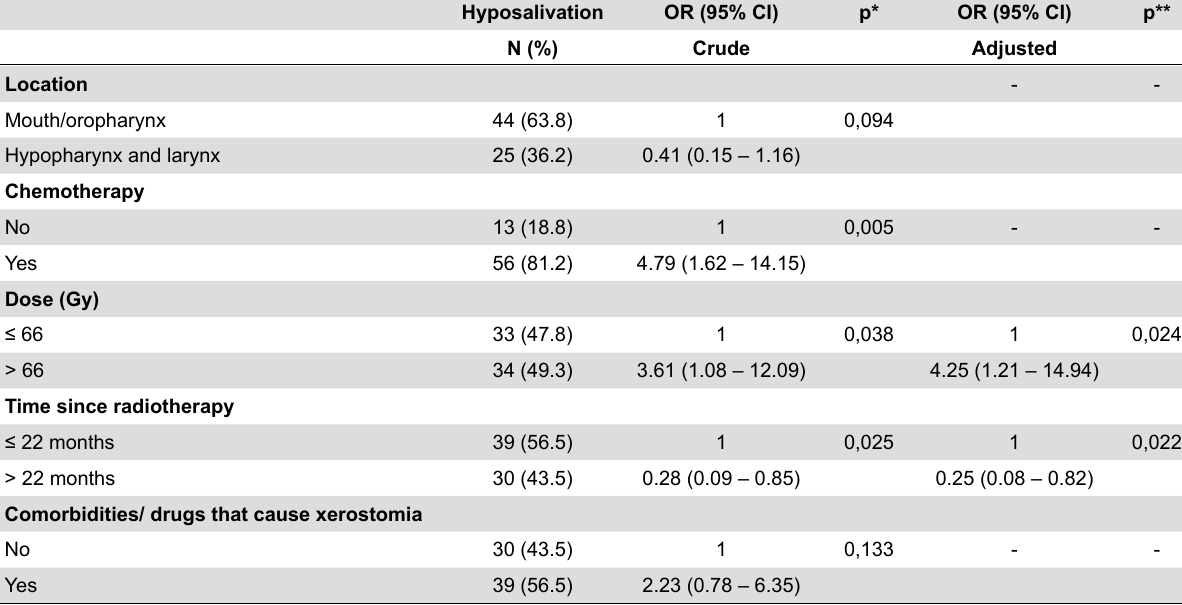
Table 3- Associations between hyposalivation and demographic, behavioral and clinical